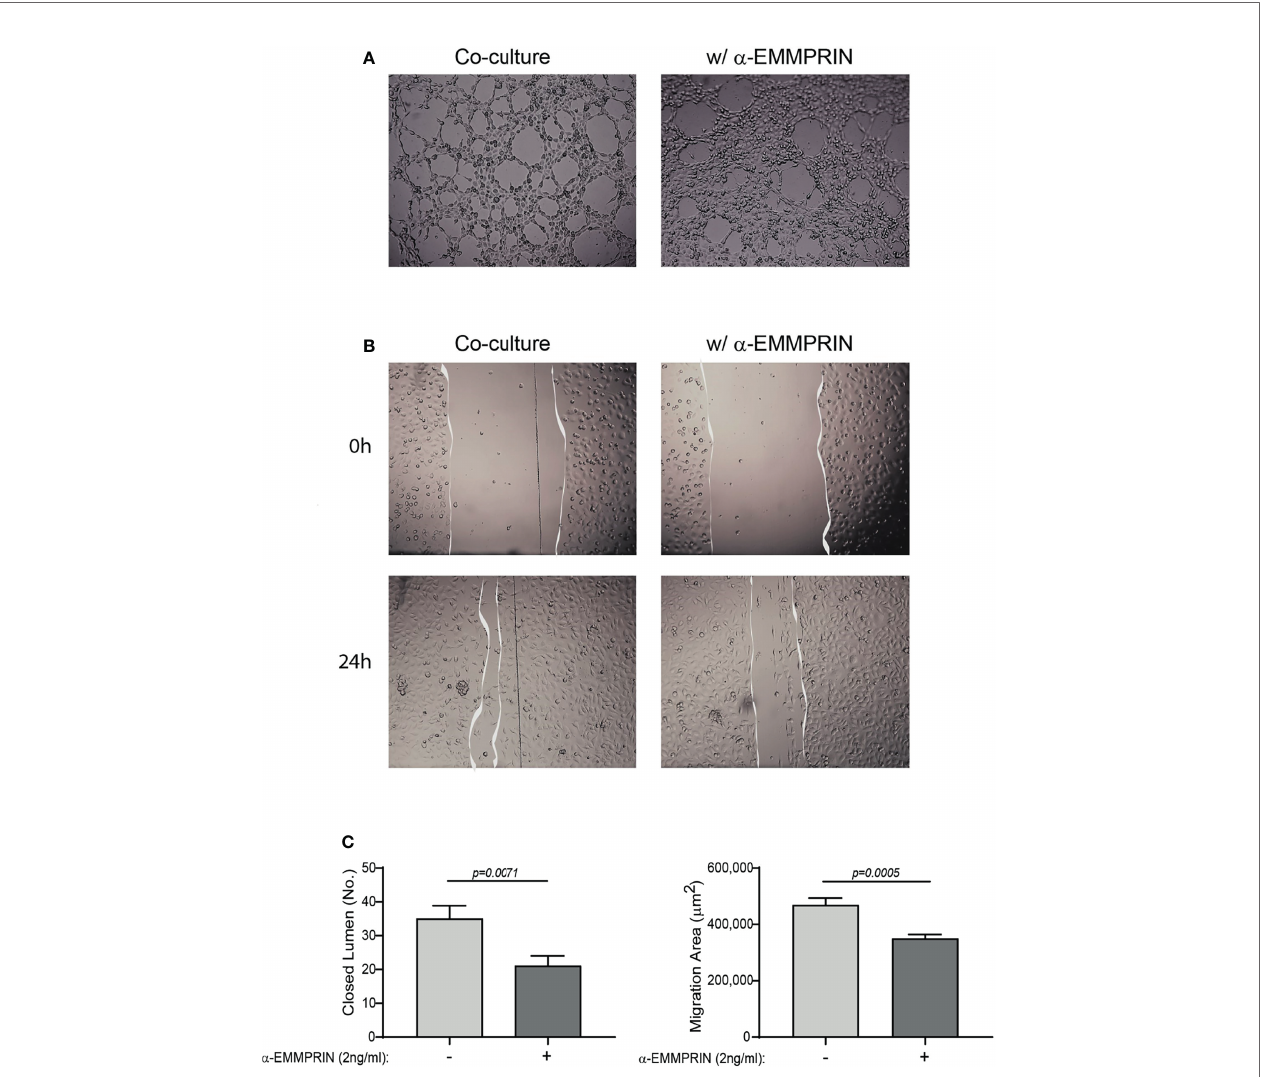
FIGURE 6 | EMMPRIN mediates the angiogenic function of the co-culture. Supernatants derived from the HT1080 and U937 co-culture experiments were collected, and diluted 1:2 in full medium with or without the addition of blocking anti-EMMPRIN antibody (2 ng/mL). This mixture was added to EaHy926 endothelial cells (8x10 4 cells/well in 200 m L) seeded on a Coulterx ® layer, and incubated for 6 hours. (A) Representative images (magni fi cation ×4), and ( C , left panel) quanti fi cation of the closed lumen tube-like structures. The unpaired t test was used (n=10). Alternatively, con fl uent monolayer of EaHy926 cells was scratched with a toothpick, detached cells were washed away, and cells were allowed to migrate for 24 hours to close the wound. (B) Representative images obtained at the beginning of the experiment (0 h) and after 24 hours (magni fi cation ×4). ( C , right panel) The area of the scratch at T24 was subtracted from the area at T0, to calculate the area endothelial cells migrated to. The unpaired t test was used